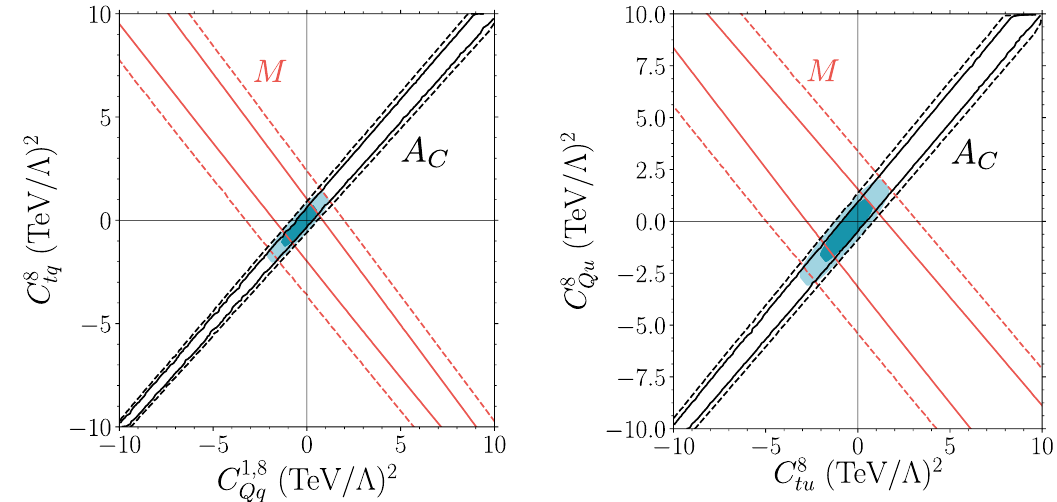
Figure 6 . Chirality e(cid:11)ects of four-quark operators from LO two-parameter (cid:12)ts to order (cid:3) (cid:0) 2 . Red lines use charge-symmetric observables (set M of table 5) while black lines use asymmetries A C . The shaded areas show the combined (cid:12)t. Solid and dashed lines mark the Gaussian equivalent of (cid:1) (cid:31) 2 = 1 ;